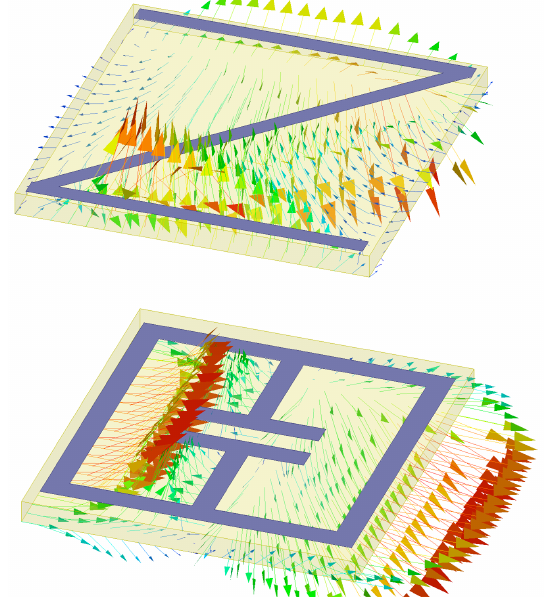
Figure 5: .Magnetic field vector distribution at resonance in the Z-shaped and ELC resonators.